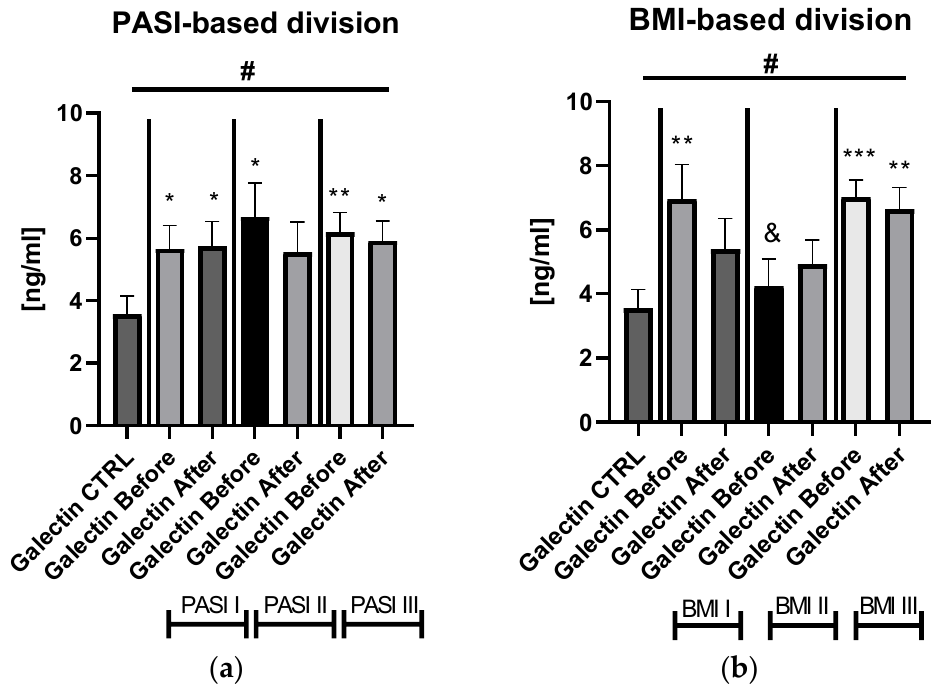
Serum galectin-3 level did not correlate with psoriasis severity expressed with PASI score ( p > 0.05) (Figure S1). After dividing the study group depending on the PASI score, the lectin concentrations were significantly higher in subjects with all three PASI subgroups before treatment, compared with the control group and remaining on similar level after therapy with statistical significance excluding the mild-to-moderate group (Figure 2a).